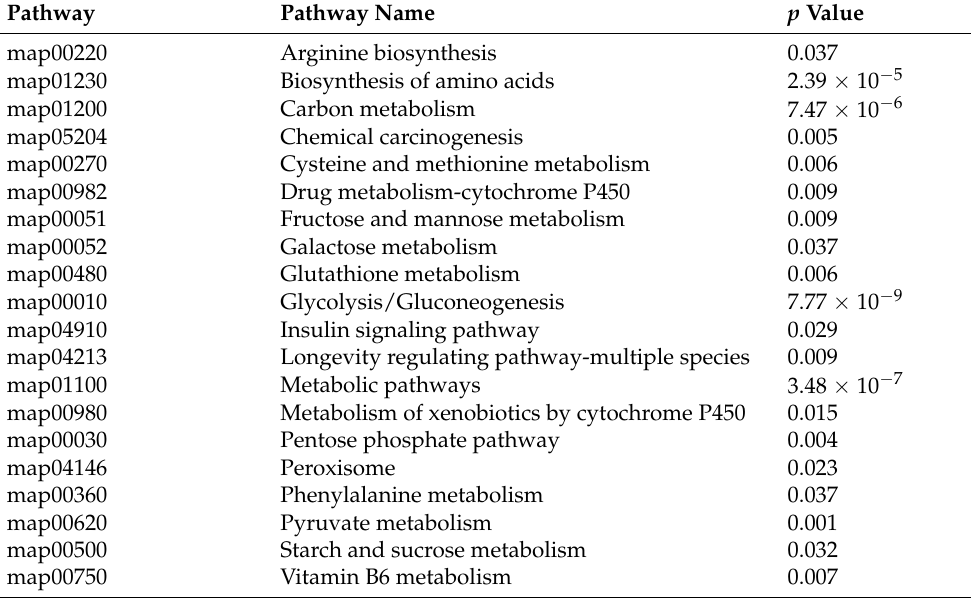
Table 5. KEGG pathway enrichment of differentially expressed proteins of 6 h vs. 0 h